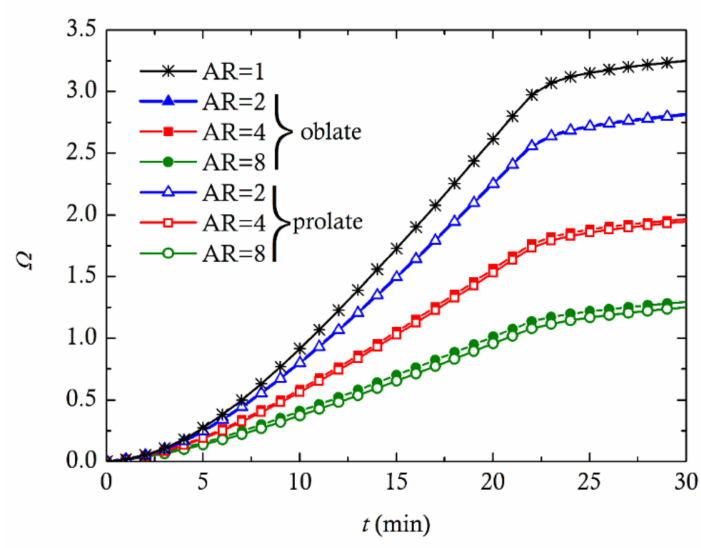
Figure 9. Evolution of thermal damage at the center of ellipsoid tumors for all analyzed